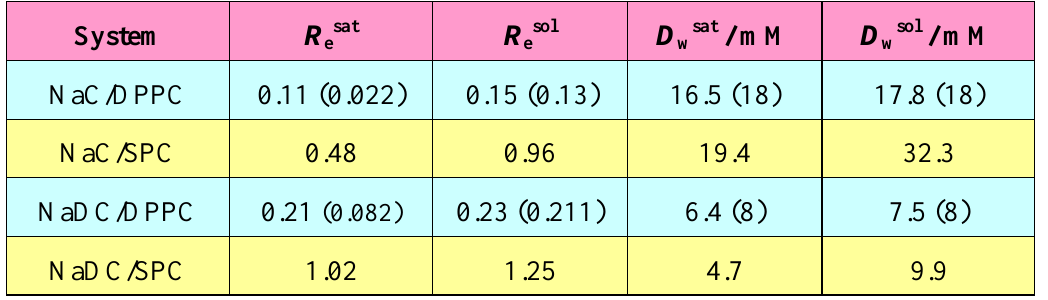
: equilibrium bile salt w